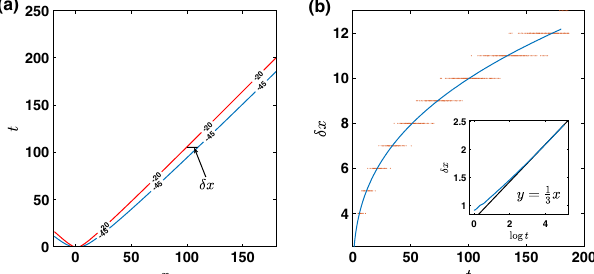
FIG. 5. The same figure as Fig. 4 but for a transverse-field Ising model describing noninteracting fermions. The slope of the curve on a log-log plot approaches 1 = 3 , agreeing with exact results for this